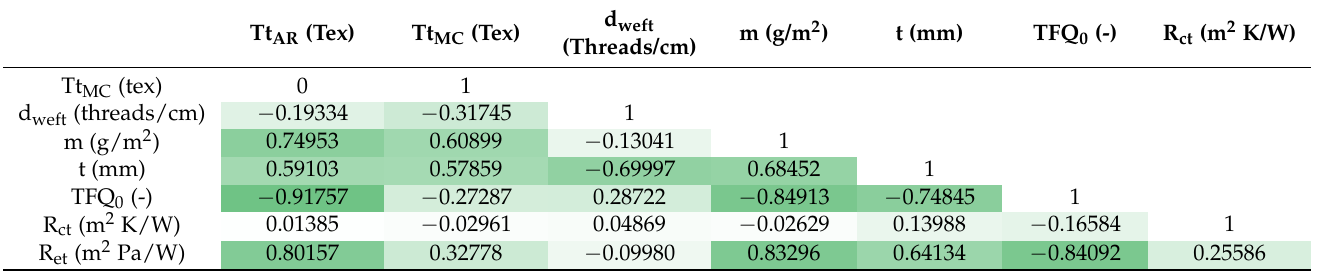
Table 6. Correlation coefficient of relevant woven fabric